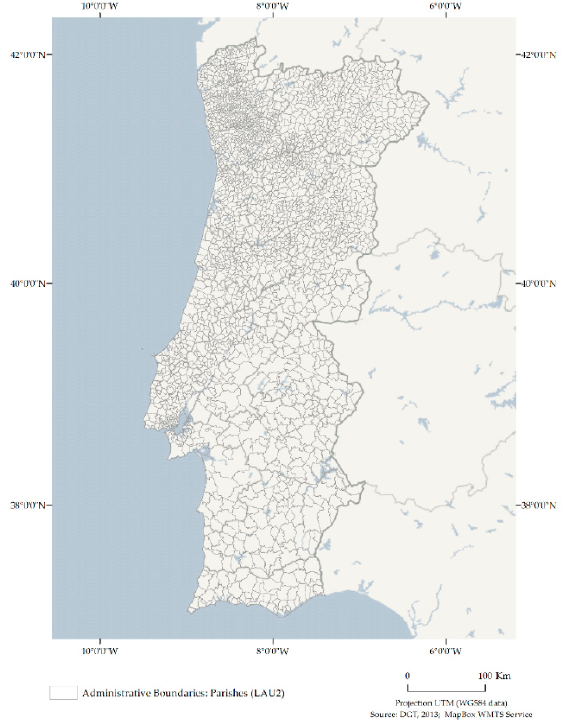
Figure 3. Mainland Portuguese territory and parish administrative boundaries in 2013.